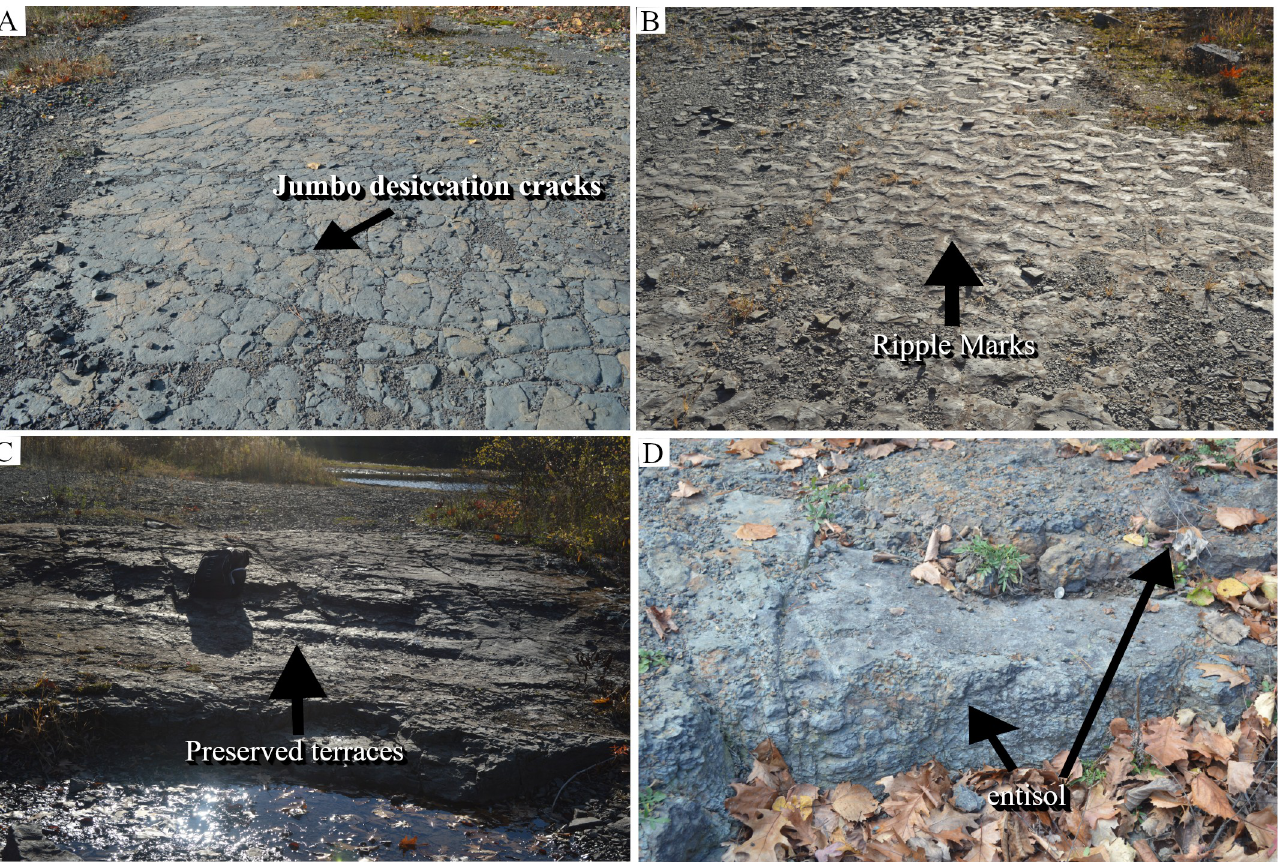
Fig 18. Preserved features of the abandoned-channel along the I-J section. (A) The wedged-shaped jumbo-desiccation cracks are oriented parallel to each other on a locally preserved mound. Regular desiccation cracks of varying shapes and sizes developed inside the jumbo cracks. (B) Sinuous-crested ripple marks on the channel floor. (C) A preserved terrace on the left bank of the local channel. (D) Paleosols with light-olive green peds on the left bank of the local channel. Note the absence of root fossils of any